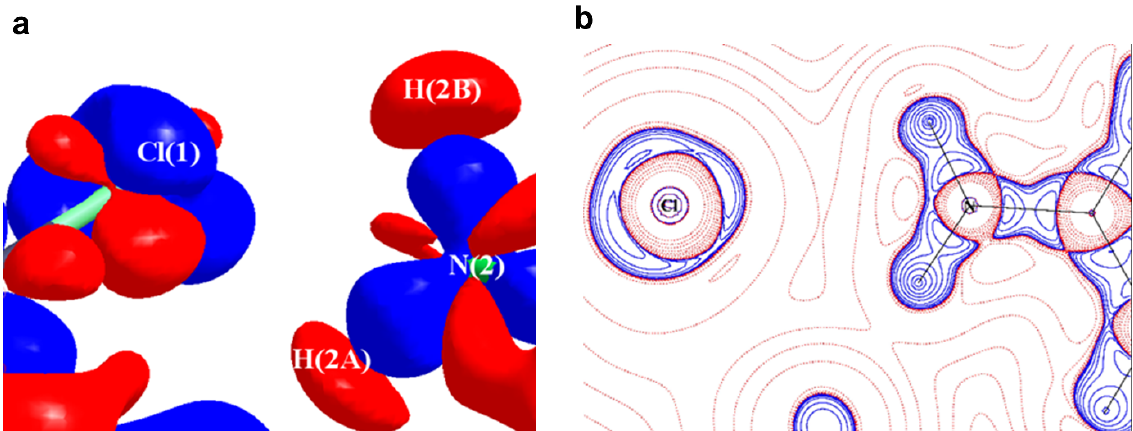
Figure 10. ( a ) Plausible N∙∙∙Cl interaction in the co-crystal of 2-amino-5-nitropyridine and chloroa- cetic acid. ( b ) Molecular Graph derived from experimental charge density model shows bond paths along with BCPs of the N∙∙∙Cl pnicogen bond and N-H∙∙∙O hydrogen bond in the structural motif (I) The yellow dots represents the (3,+1) ring critical points (RCP) while the red dots represent the (3,−1) BCPs. The curved segments signify the bond paths between atoms. Figure reproduced from refer- ence [69] .